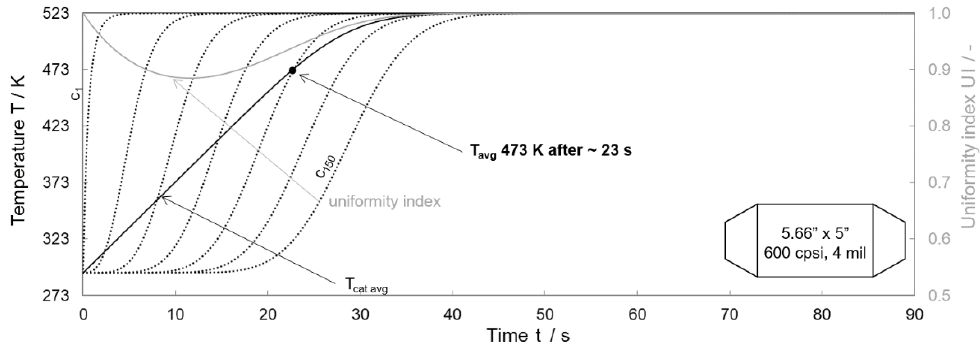
Figure A2. Heat-up of 600 cpsi, 4 mil with reduced length at steady state heat-up.